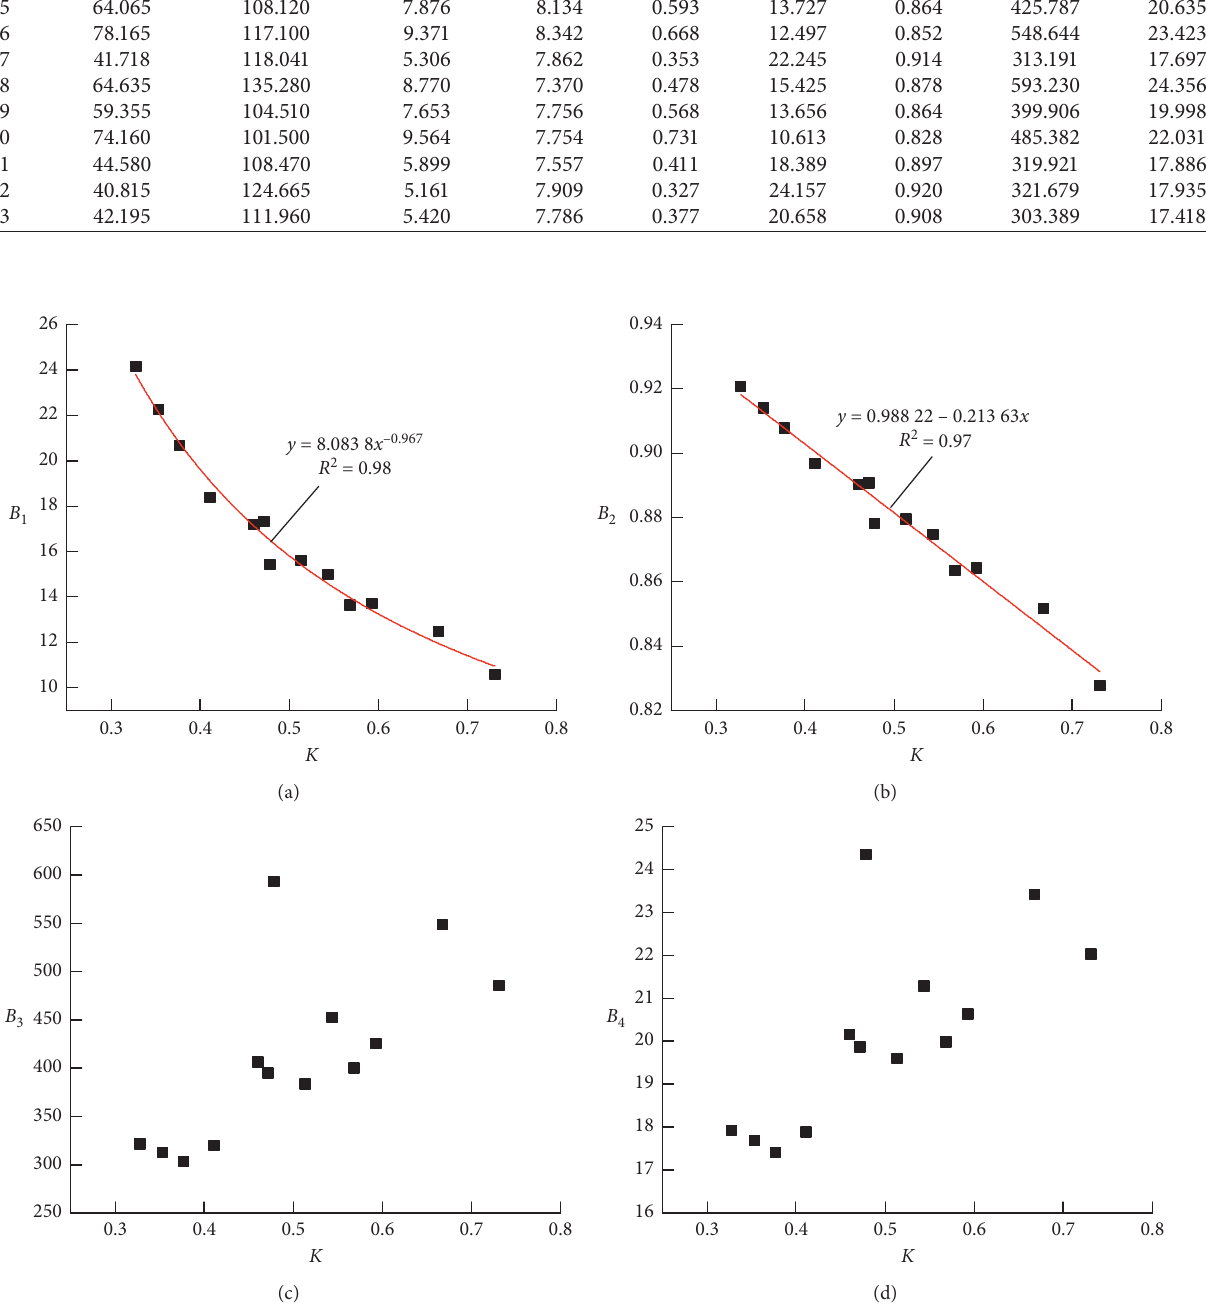
1 ; (b) B 2 ; (c) B 3 ; (d) B 4